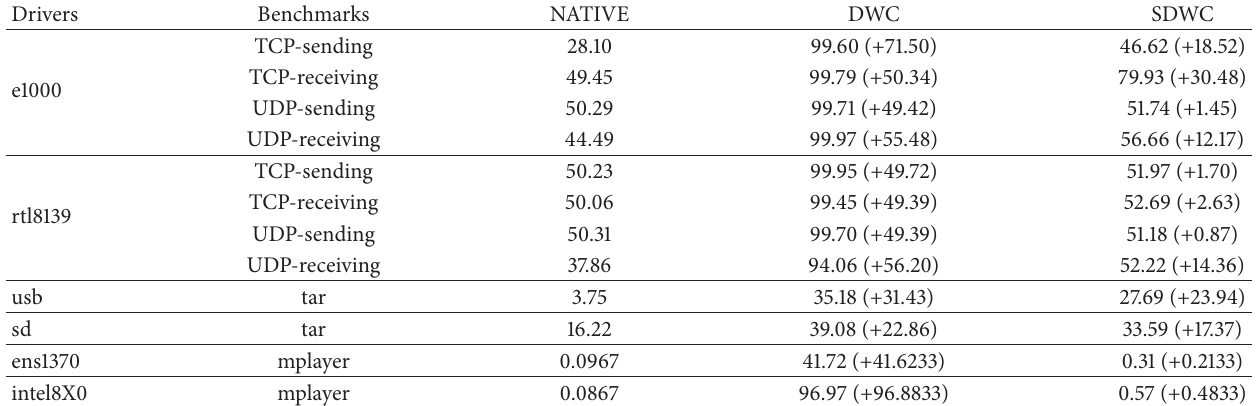
Table 2: The CPU utilization (%) of drivers, in the bracket is delta CPU utilization according to